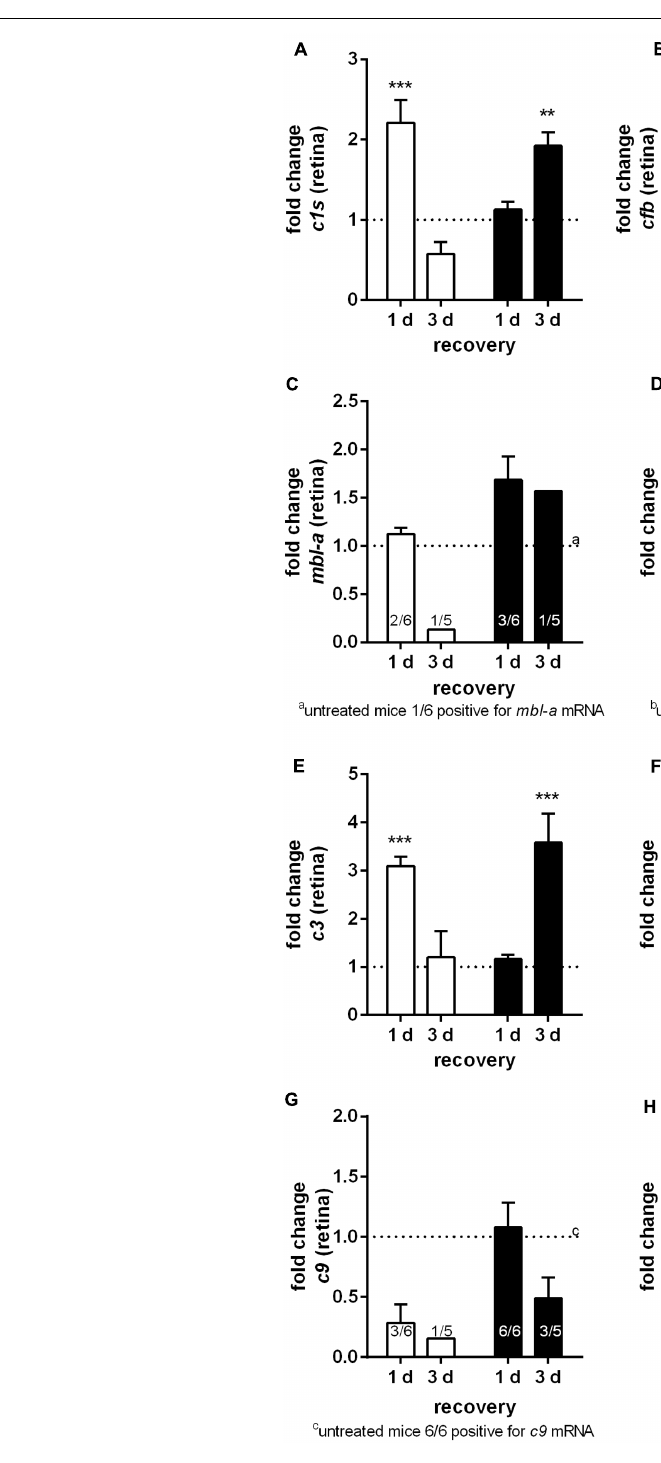
FIGURE 2 | Retinal transcription of complement factors changed dependent on the recovery time after different light treatment regimens. mRNA expression was analyzed in the retinae of mice treated either with constant (1000 lux, 24 h; white bars) or acute white light (5000 lux, 0.5 h; black bars) and compared to untreated controls. (A) c1s , (B) cfb , (C) mbl-a , (D) masp-1 , (E) c3 , (F) c4 , (G) c9, and (H) cfp mRNA was determined. (A) C1s , (B) cfb , (E) c3 , and (F) c4 mRNA was significantly elevated either at 1 day following constant (white column) or at 3 days following acute (black column) light treatment. (G,H) C9 and cfp mRNA expression was decreased following LD. Data represent mean values + standard error of the mean. (C) mbl-a , (D) masp-1 and (G) c9 mRNA was partly detected. Positive animals were indicated as small numbers in the bars. Mean of untreated control shown as dotted line. ∗ 0.01 < P < 0.05, ∗∗ 0.001 < P < 0.01, ∗∗∗ 0.0001 < P < 0.001, and ∗∗∗∗ P < 0.0001 (ordinary one-way ANOVA, Dunnett’s multiple comparisons test, with a single pooled